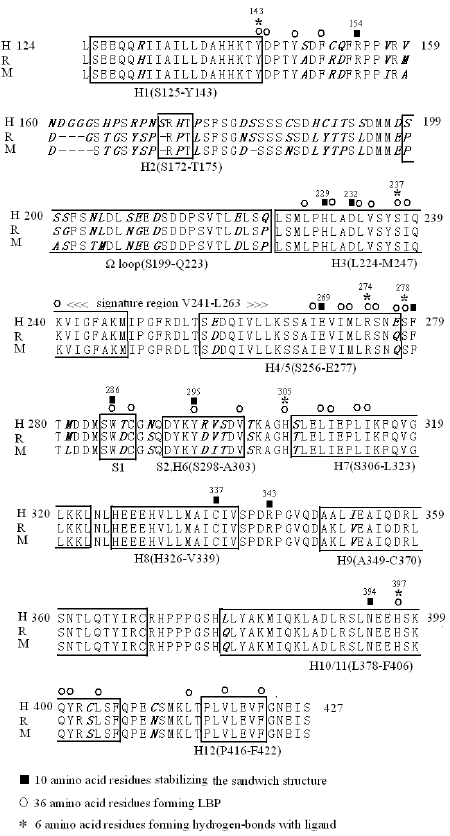
Figure 1. Alignment of a portion of the VDR LBD of human, rat and mouse. The amino acid sequence of VDR LBD extends from residues 142 to 427 in humans, to 423 in rats, and to 422 in mice. The closed boxes indicate the position of the 12 α -helices and the 2 β -strands, forming a β -sheet and H3n (SVTLE) between residues 216–220. Ten solid bars above the VDR sequence correspond to the amino acid residues in the VDR LBD which stabilize the sandwich structure and 36 closed rings above the VDR sequence corresponding to amino acid residues in the VDR LBD which form LBP. Among them, six asterisks represent polar amino acid residues within a 3 Å distance from 1,25(OH) 2 D 3 which form hydrogen-bonds with the ligand. Only VDR LBD including the Ω loop of 25 residues from S199 to Q223 cannot exist in other NRs.